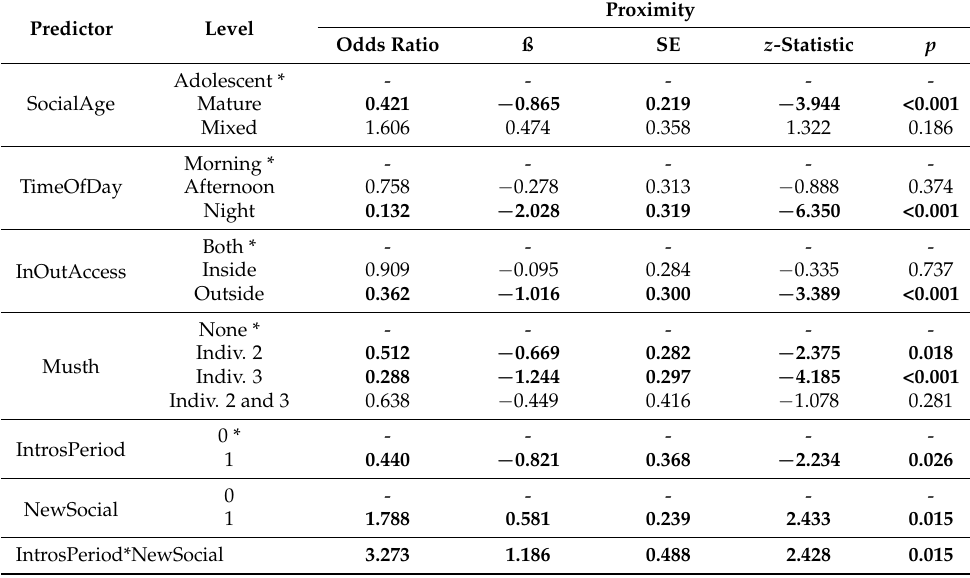
Table A6. Adolescent GLMER model parameter estimates for proximity response variable. General- ized linear mixed-effect model results of associations between predictor variables (fixed effects) and proximity response variable for adolescent focal animals. ß = Beta coefficients from model outputs: positive values indicate an increase in odds compared to the reference level while negative values indicate a decrease in odds compared to reference level; SE = standard error of beta coefficients; Wald X 2 = Chi-squared statistic from Wald test with df = 1; p = p -value from Wald test. * indicates reference level. Bold signifies statistical significance ( p < 0.05).